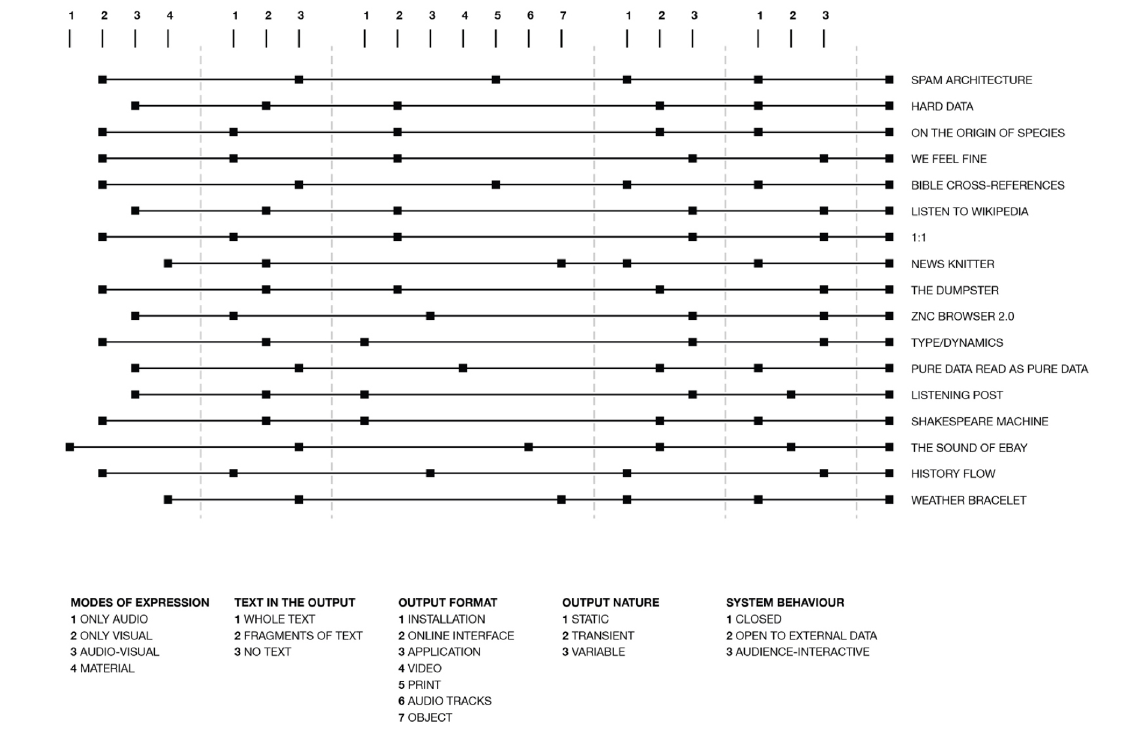
Figure 9 | Analysis graph: experience dimension – observation of artwork’s surface expression and system